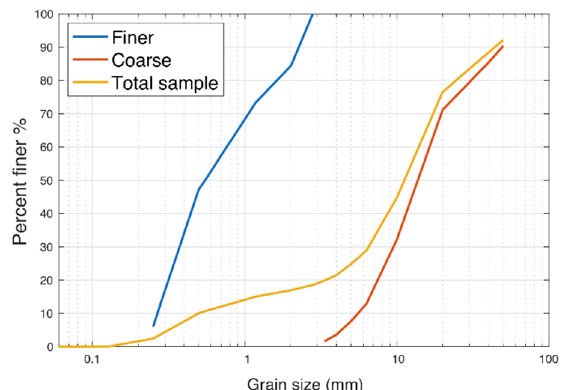
Figure 9. Sediment unit / grain size distribution curves.